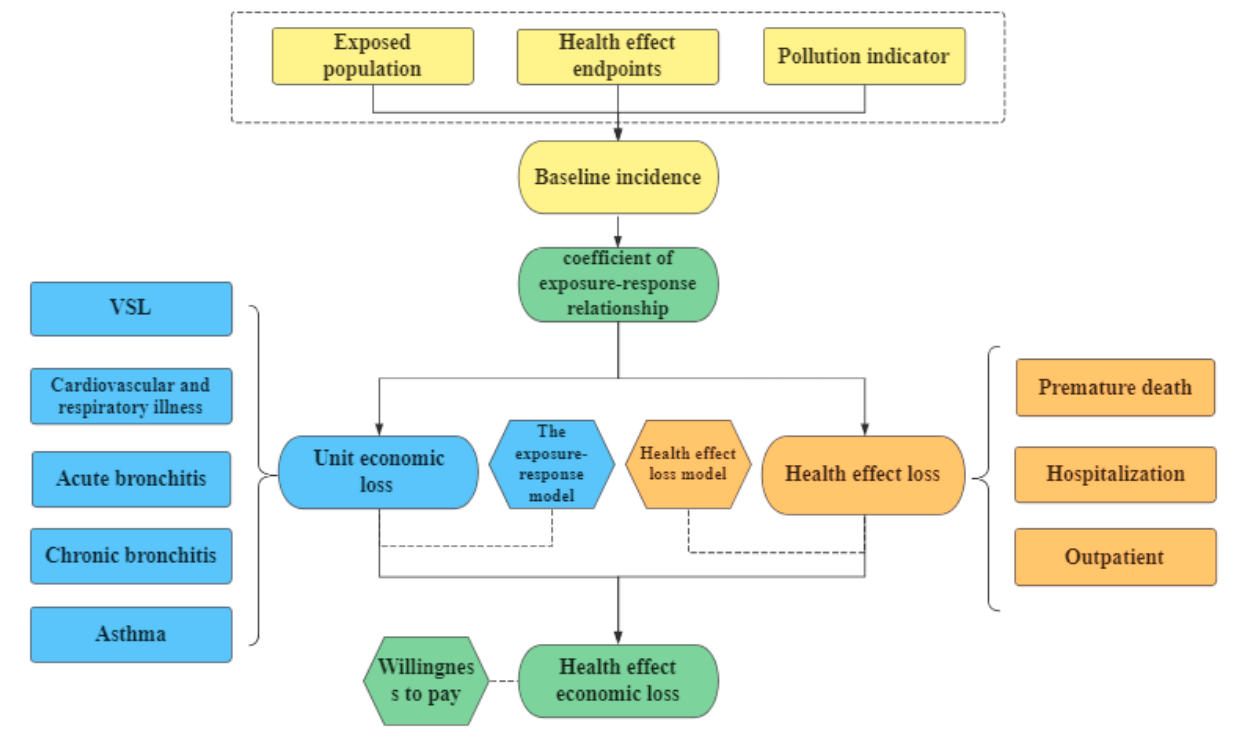
Figure 1. Roadmap. Figure 1.